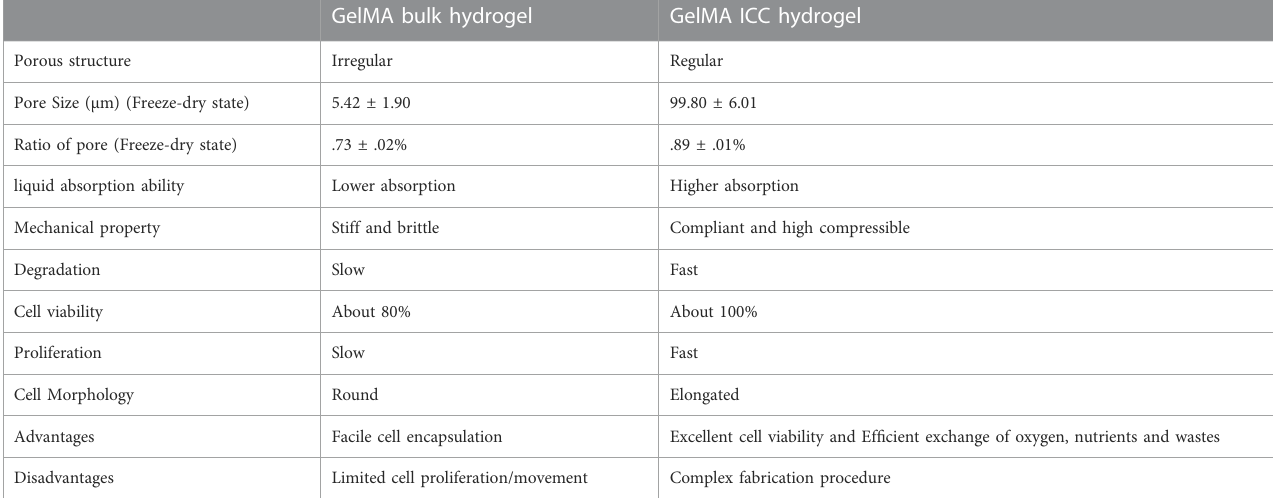
TABLE 1 A difference of GelMA bulk and ICC hydrogels in pore structure, physical properties, mechanical properties, and cell behaviors. GelMA bulk hydrogel GelMA ICC hydrogel Porous structure Irregular